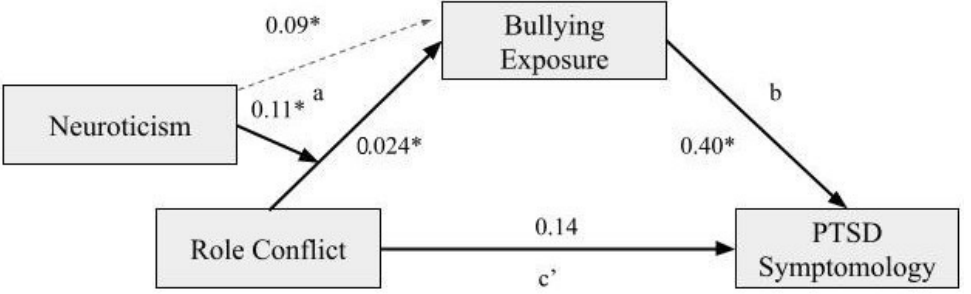
Figure 2. Coefficients of the moderated mediation model with neuroticism as a moderator. Note. * indicates p < 0.05. c’ (c-prime) refers to the direct effect.